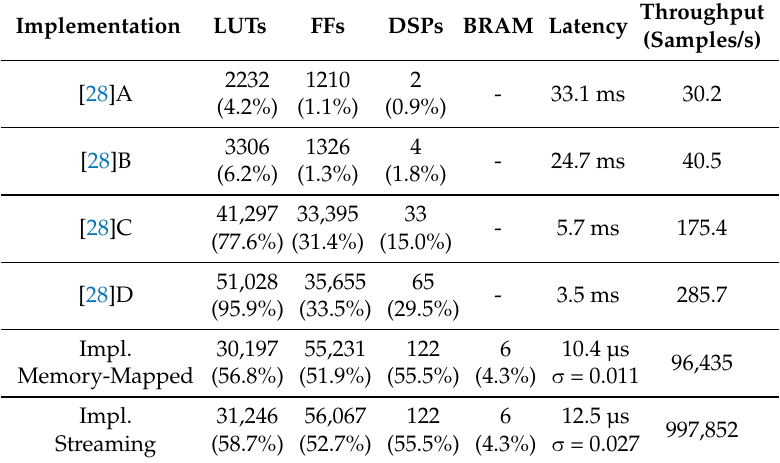
Table 3. Implementation resource use and benchmark result comparison table with [28] (Theoretical II = 100, Theoretical Latency = 987). (LUT-Look-up-Table, FF-Flip Flop, DSP-Digital Signal Processor core, BRAM-Block Random Access